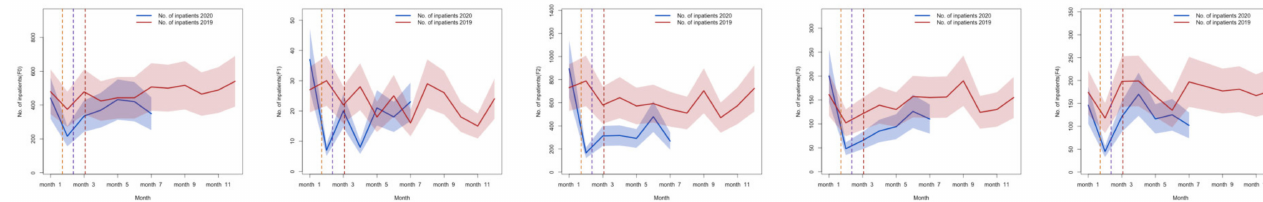
Figure 5. Utilization of the five major types of mental illness services from January 2019 to July 2020. Legend: The five major types of mental illness services utilization from January 2019 to July